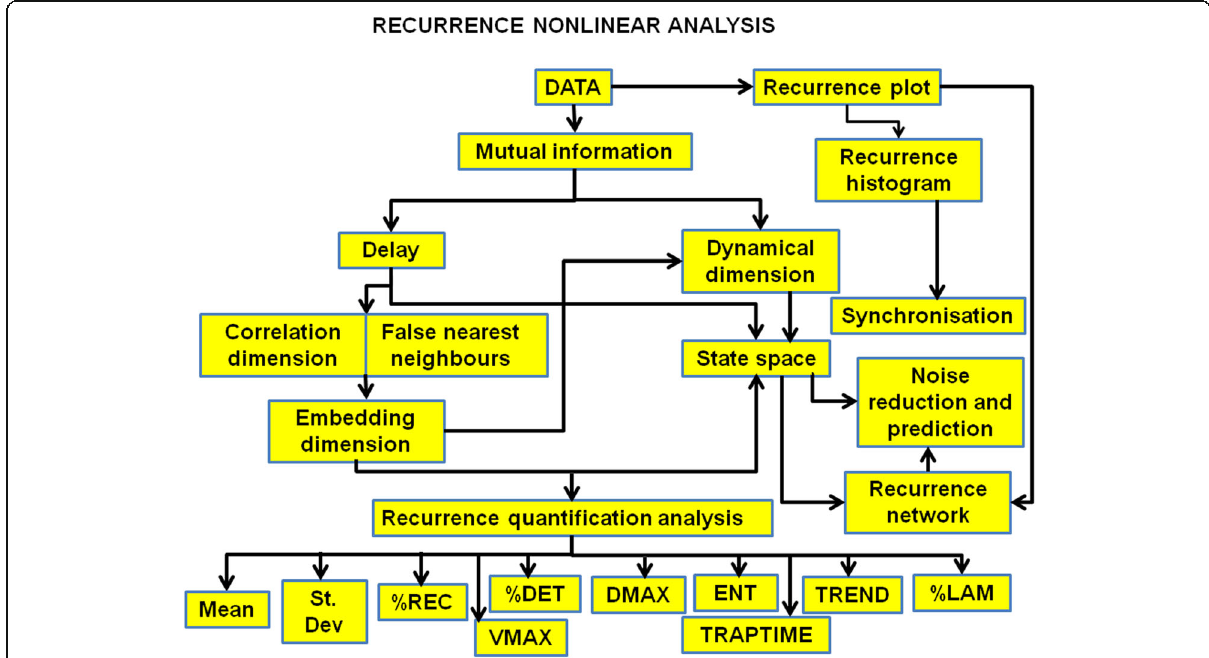
(with a change in frequency), periodic → chaotic or chaotic → chaotic. A vertical line represents an interval where the state does not change or changes relatively slowly but the state of the system changes across the line. A summary of the significance of various patterns on recurrence plots is given in